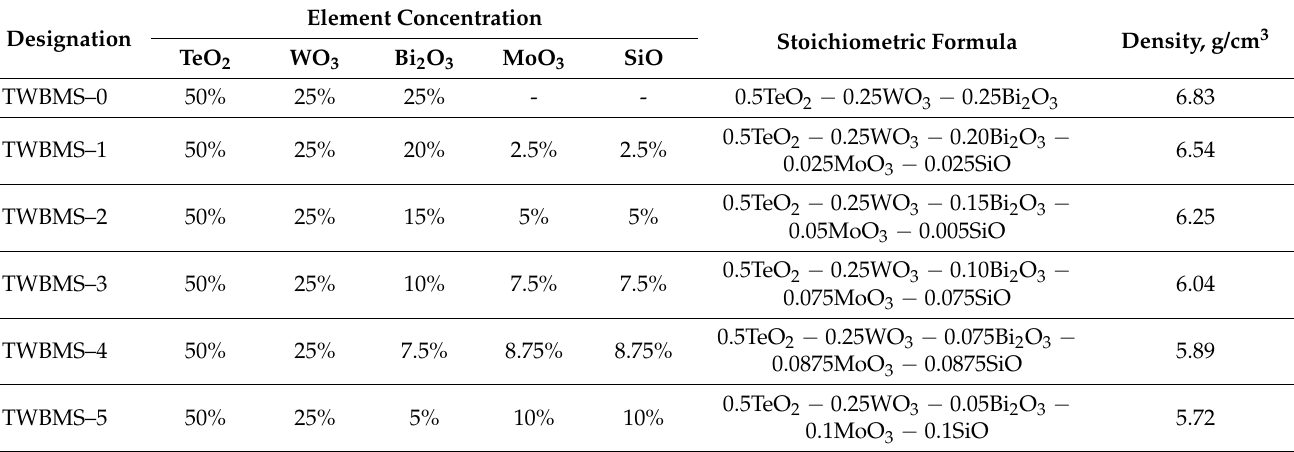
Table 1. Component content